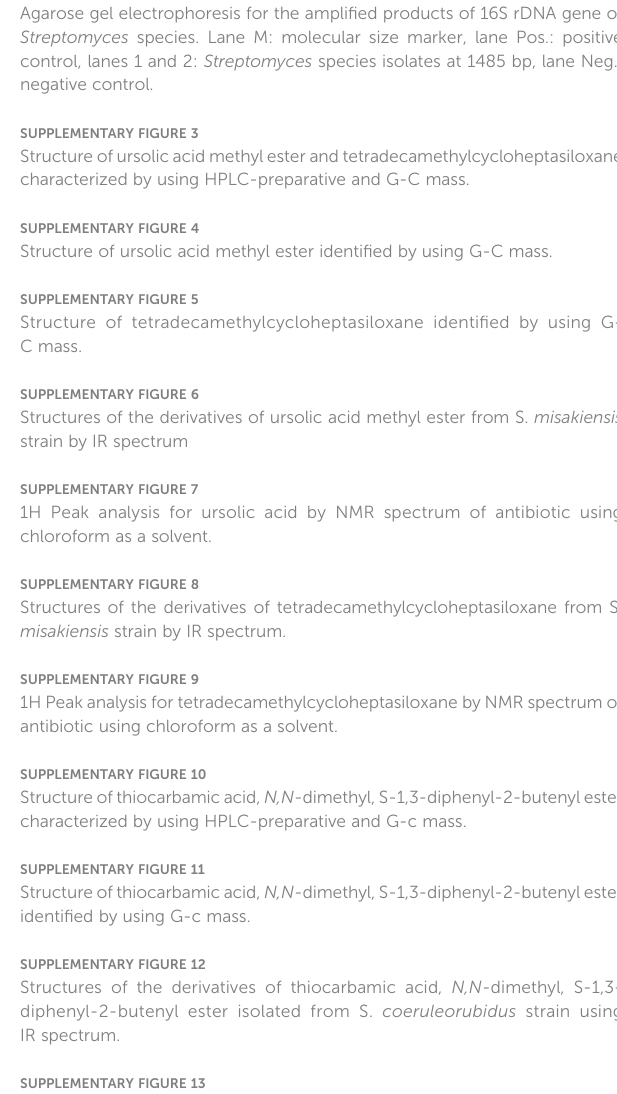
Streptomyces species. Lane M: molecular size marker, lane Pos.: positive control, lanes 1 and 2: Streptomyces species isolates at 1485 bp, lane Neg.: